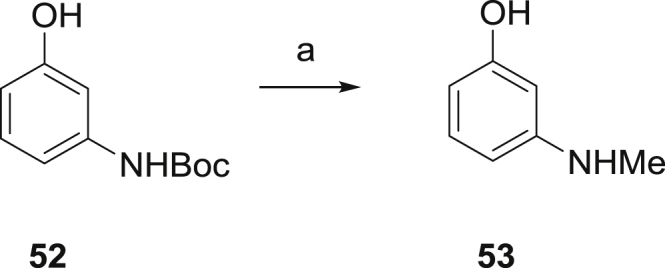
Synthesis of 53. aReagents and conditions: (a) LiAlH4, THF.